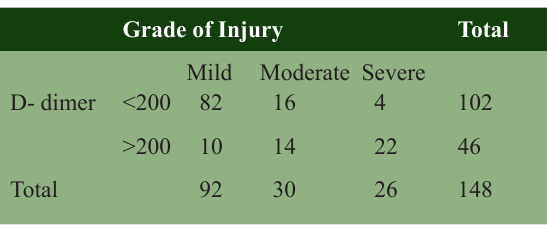
Chi-Square tests